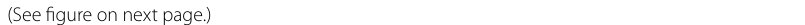
figure on next Fig. 6 FoxO3a regulates HTR8/SVneo cells migration progress. A The heatmap illustrates the copy numbers of mRNAs. Red represents higher transcription, and green represents lower transcription. B Enriched Gene Ontology (GO) analysis illustrated that migration of HTR8/SVneo cells was the most affected biological process after FoxO3a exhaustion. C Correlation analysis between transcriptomics and metabolomics. Red represents positive correlation, and blue represents negative correlation. D qPCR shows reduced expression of the genes (COX‑2 and MMP9). Only the results showing statistically significant Student’s t‑test ( P < 0.05) and minimum false discovery rate (q < 0.05) are shown, n